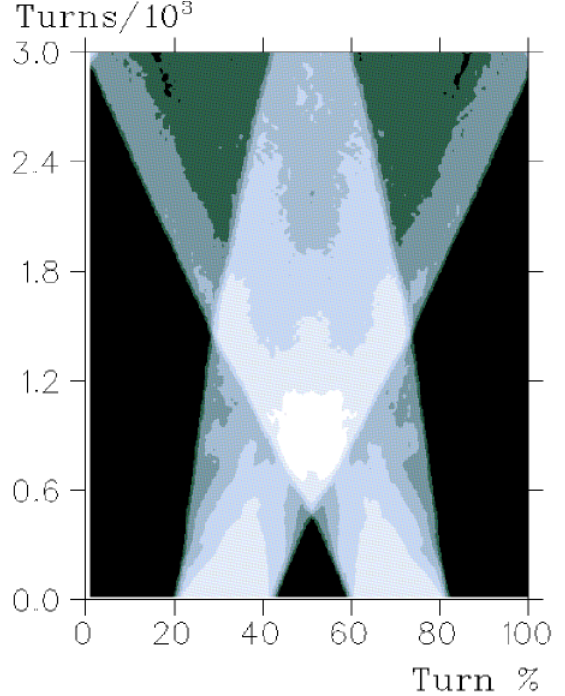
FIG. 30. Waterfall plot of line density, 3000 turns. Two holes debunch, 2.5 3 10 12 protons, 2.2 3 10 5 macroparticles.